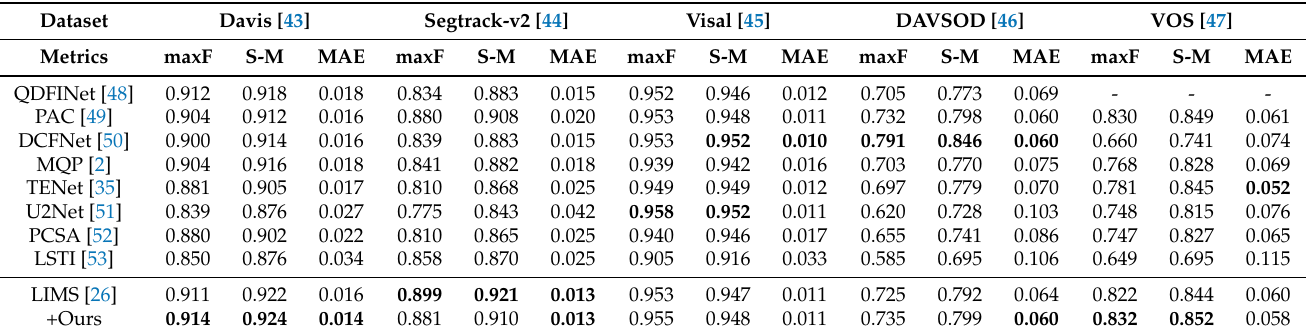
Table 7. Comparison with current mainstream saliency detection models, “+Our” means fine-tuning LIMS using the optical flow model proposed in this paper, and the optimal data are shown in bold.